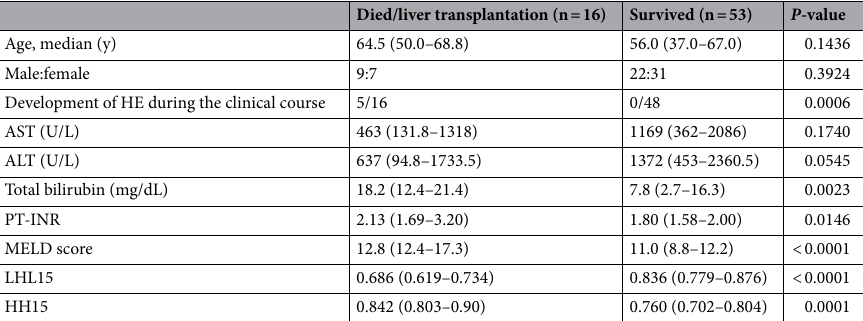
Table 2. Demographic data classified according to outcome. Data are presented as n (%) or median (interquartile range [IQR]). HE hepatic encephalopathy, AST aspartate aminotransferase, ALT alanine aminotransferase, PT-INR prothrombin time-international normalized ratio, MELD model for end-stage liver disease, LHL15 Hepatic accumulation index calculated by dividing the radioactivity of the liver regions of interest by that of the liver-plus-heart regions of interest at 15 min. HH15, Blood clearance index calculated by dividing the radioactivity of the heart regions of interest at 15 min by that at 3 min.